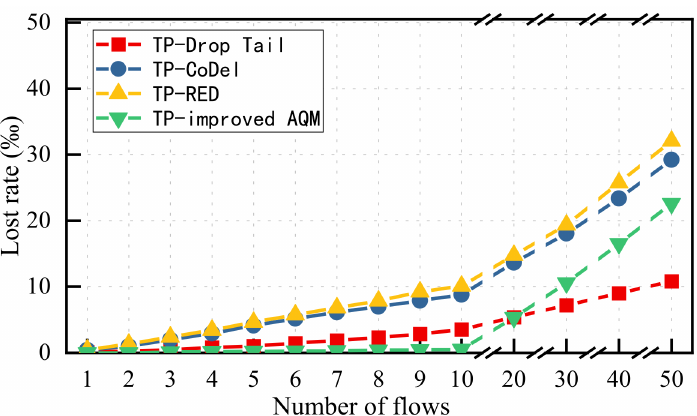
Figure 11. The loss rate under different numbers of ICN